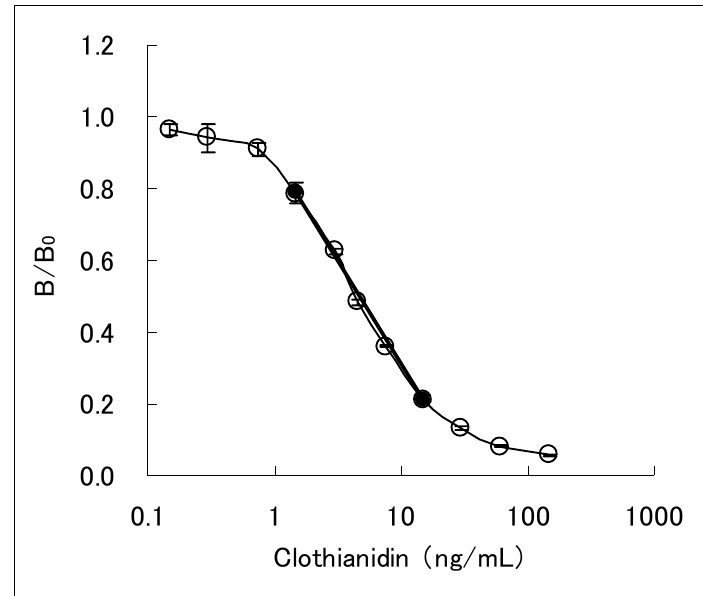
and IC values ( ● ) shows 20 80 shows ratio between absorbance for clothianidin 0 ) at 450 0